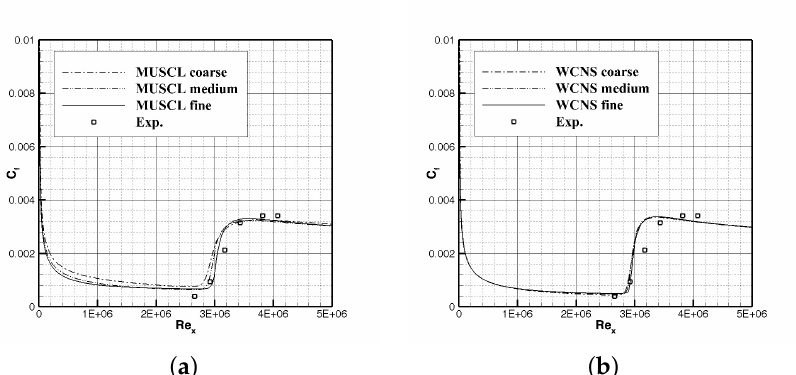
Figure 4. Comparison of machine-learning-coupled CFD based on MUSCL and WCNS of different set of meshes. ( a ) MUSCL. ( b ) WCNS.